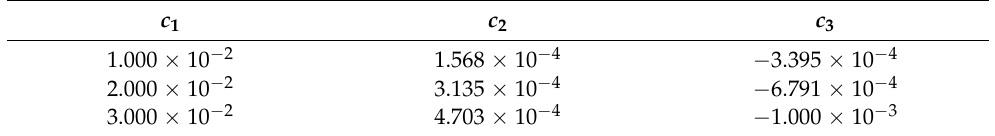
Table 2. Damping parameters [27].